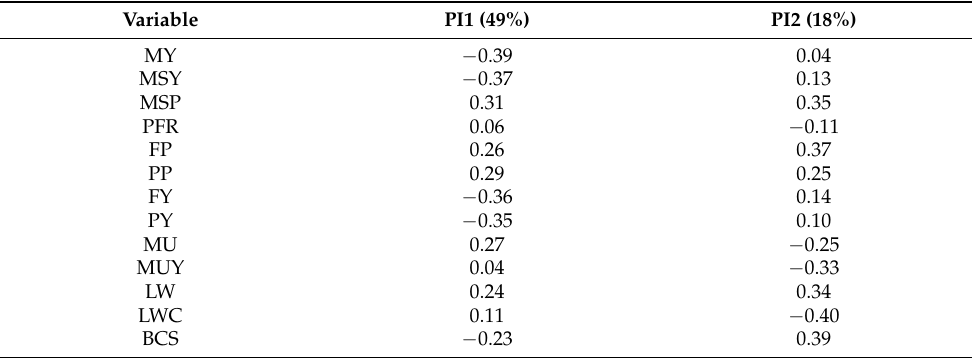
Table 2. Principal component loadings that were used to define overall performance indices 1(PI1) and 2 (PI2) based on the combination of performance per cow variables. Variance is explained by the PI within brackets.